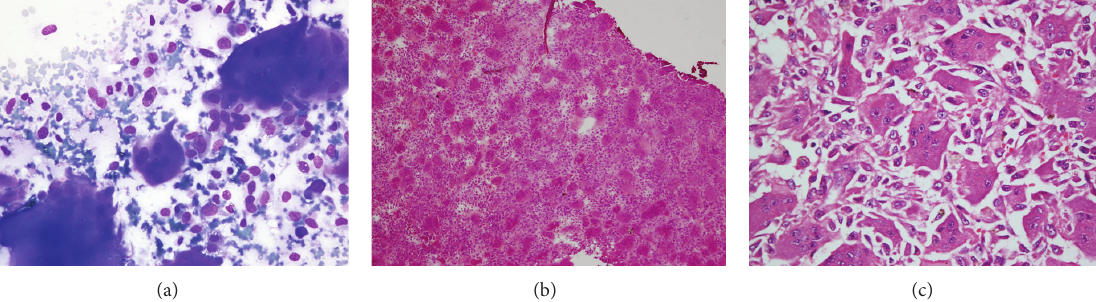
Figure 3: (a–c) Giant cell tumor: (a) multinucleate giant cells with nuclear morphology similar to that of background stromal cells in imprint smear (MGG stain, × 400); (b) uniformly distributed osteoclastic giant cells in a background of bland stromal cells noted in frozen section (H&E, × 100); (c) paraffin-embedded section confirming giant cell tumor (H&E, × 400).